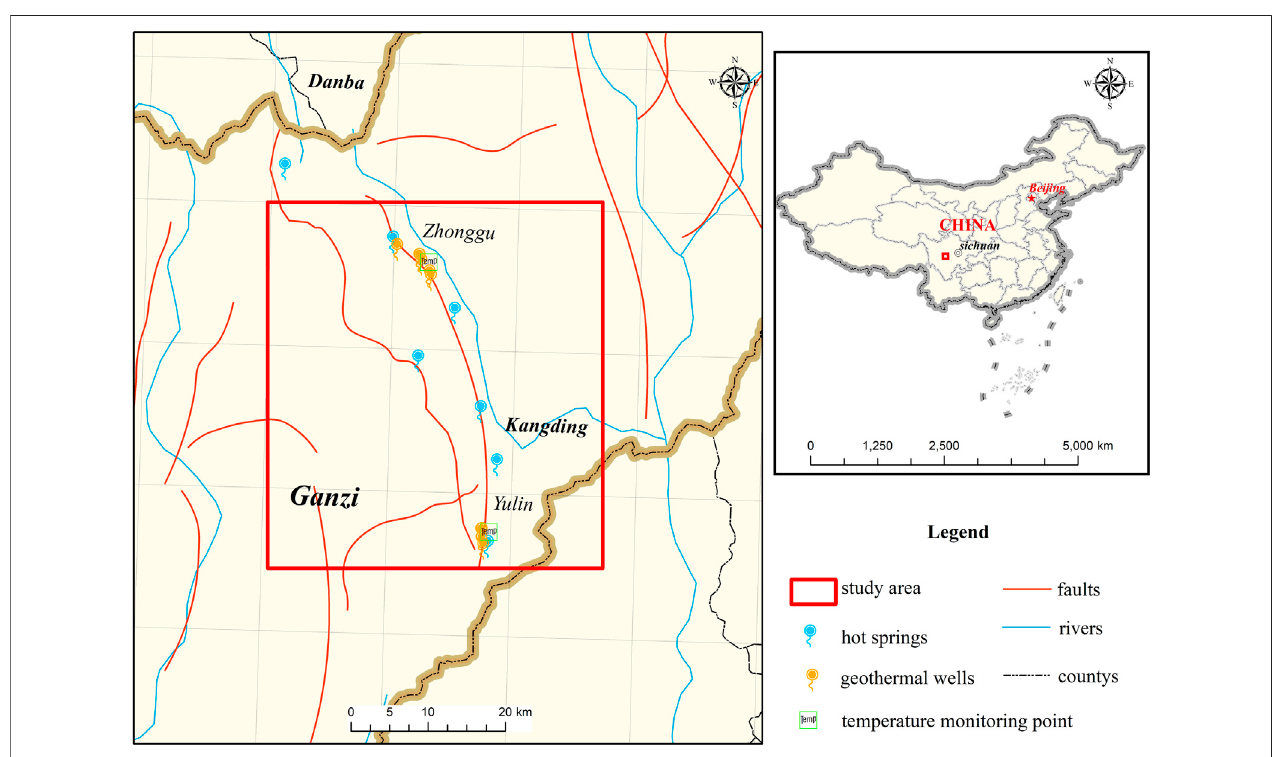
FIGURE 1 | Geographical location and tectonic map of the study